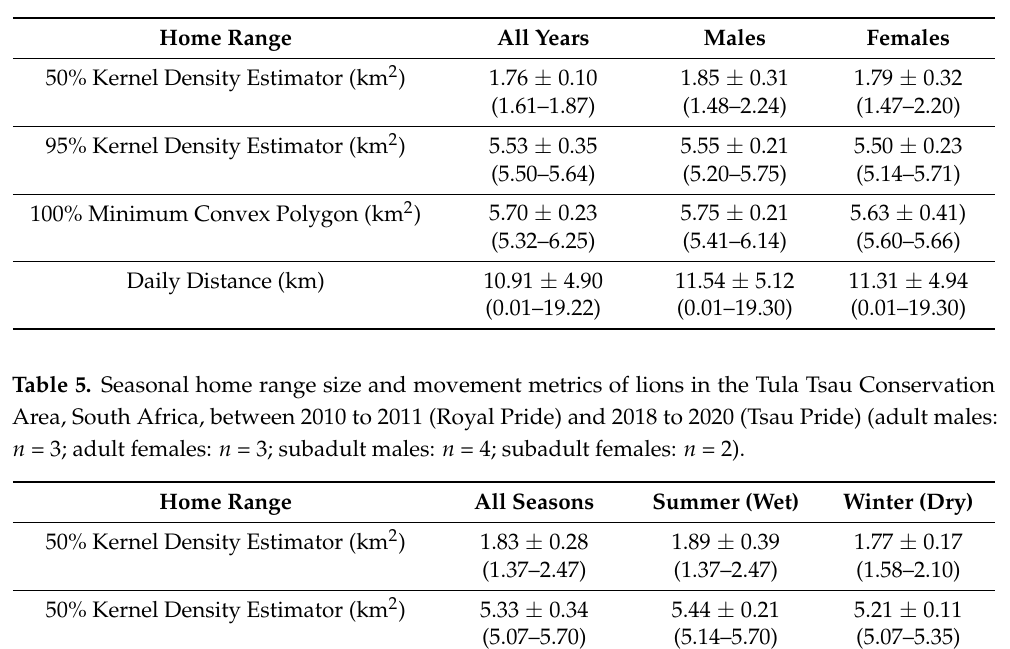
Table 4. Annual home range size and movement metrics of lions in the Tula Tsau Conservation Area, South Africa, between 2010 to 2011 (Royal Pride) and 2018 to 2020 (Tsau Pride) (adult males: n = 3; adult females: n = 3; subadult males: n = 4; subadult females: n = 2).